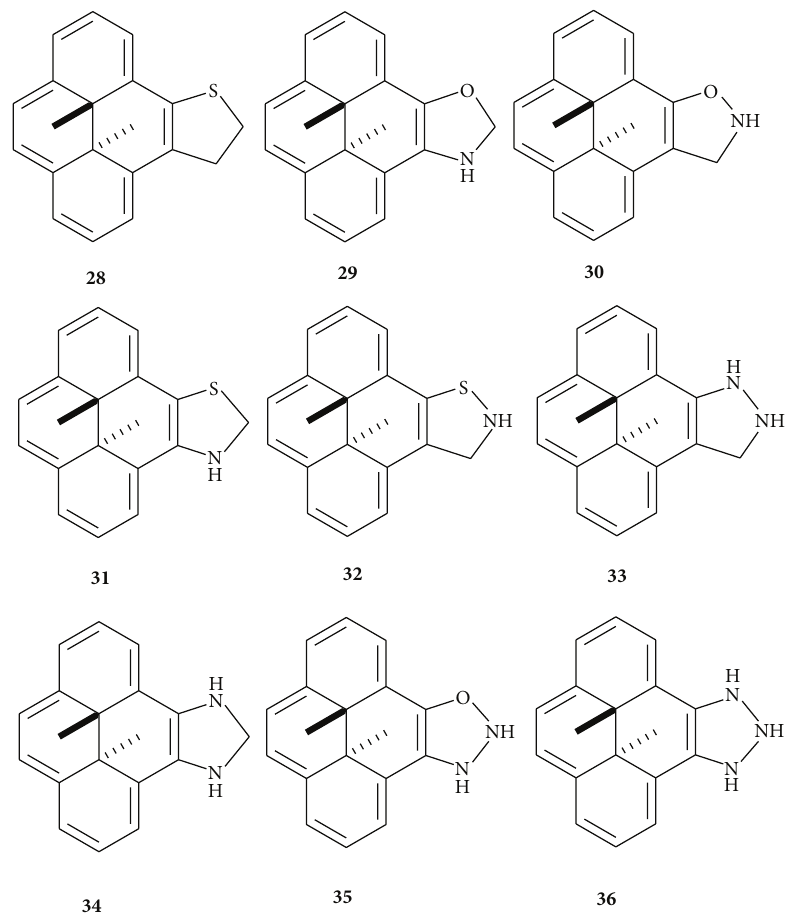
Figure 6: Nonaromatic model for heterocyclic arene fused dihydropyrene, for the quantification of aromaticity through (5).